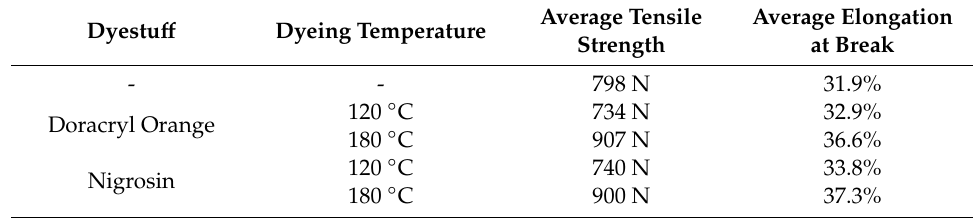
Table 1. Mechanical properties of amorphous m-aramid fabrics after dyeing in EMIM-EtSO 4 with Doracryl Orange and Nigrosin at 120 ◦ C and 180 ◦ C, respectively.